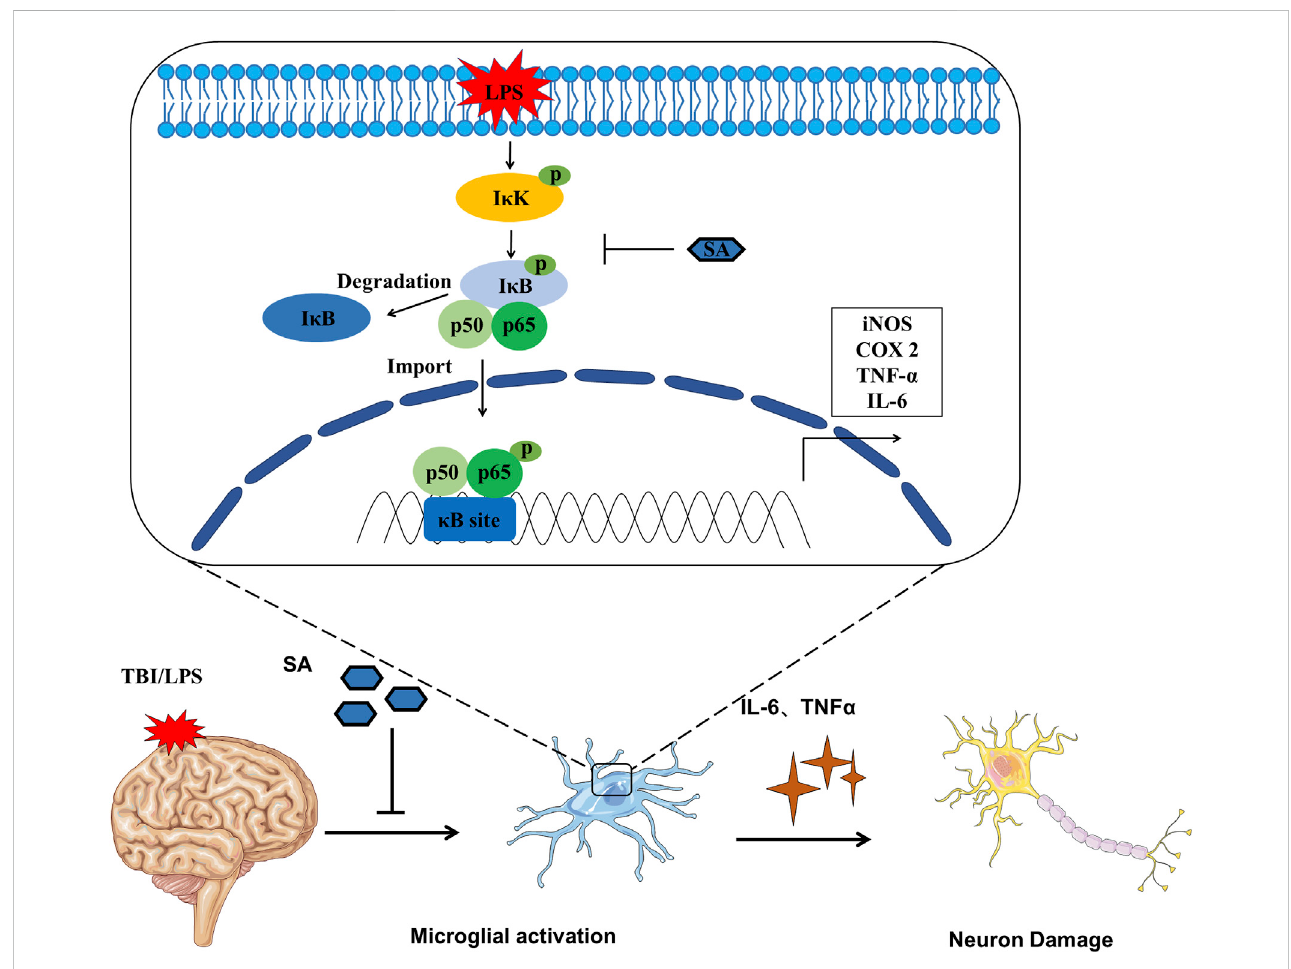
FIGURE 6 Schematic diagram SA inhibiting microglia activation and exerting neuroprotective